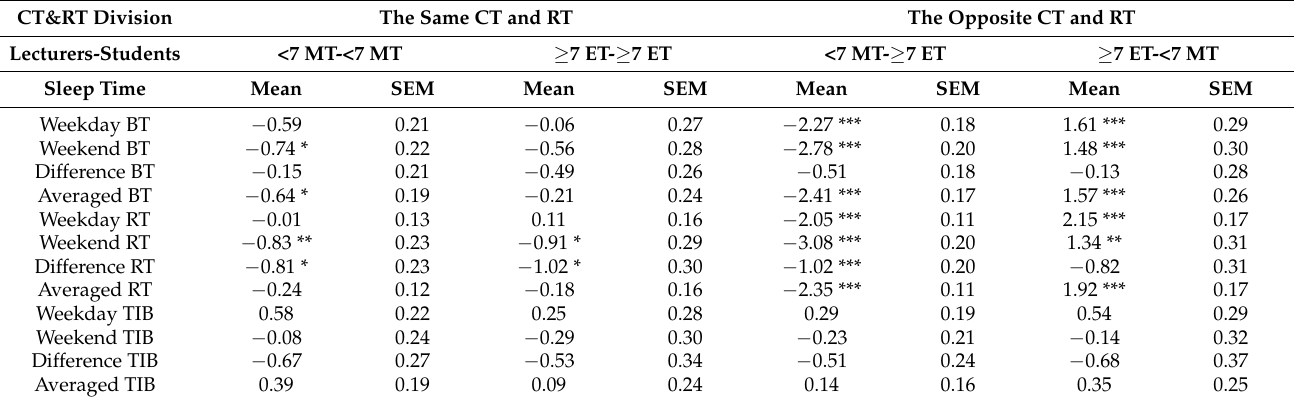
Table 5. Differences between lecturers and students in some of the